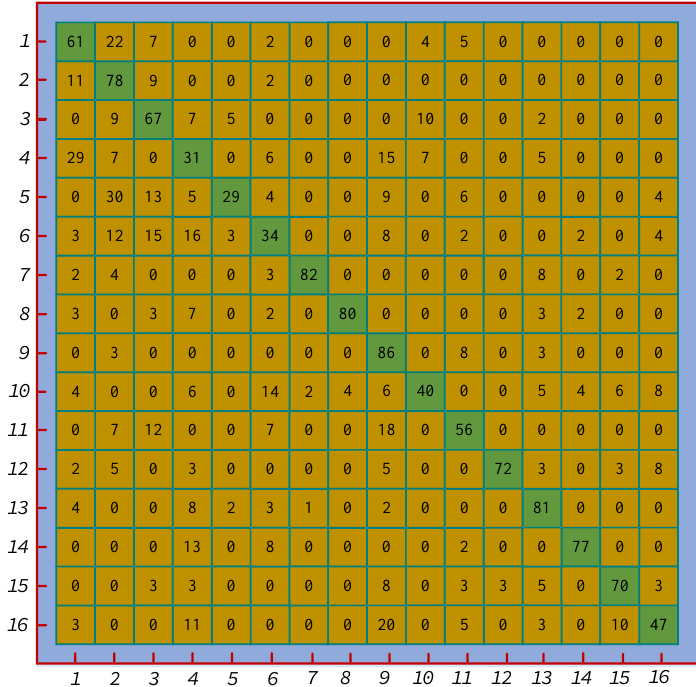
Figure 8. Confusion matrix of the LBP & SVM. Each row corresponds to the ground truth labels and each column corresponds to the recognition labels.